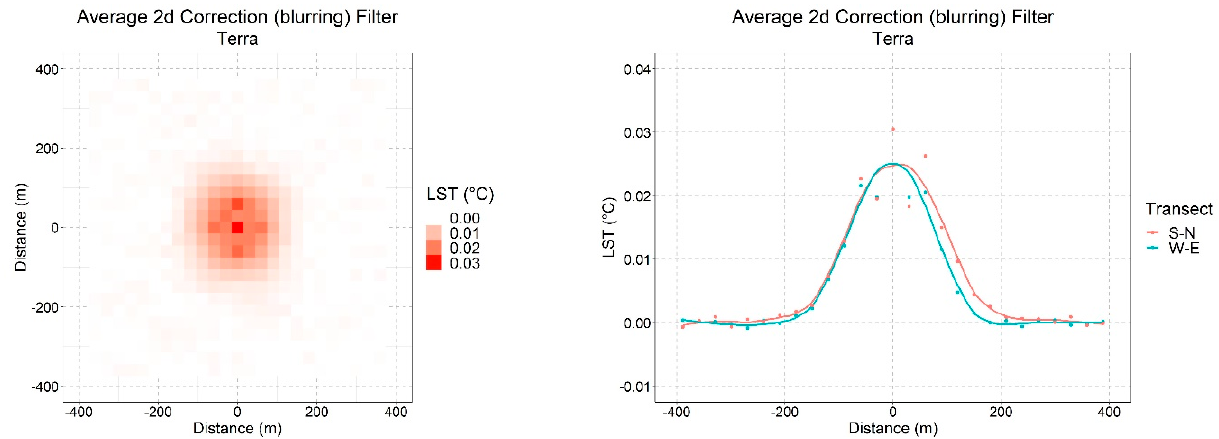
Figure 9. 2d correction (blurring) filter as a raster ( left ), and S-N and W-E-transects through the raster ( right )